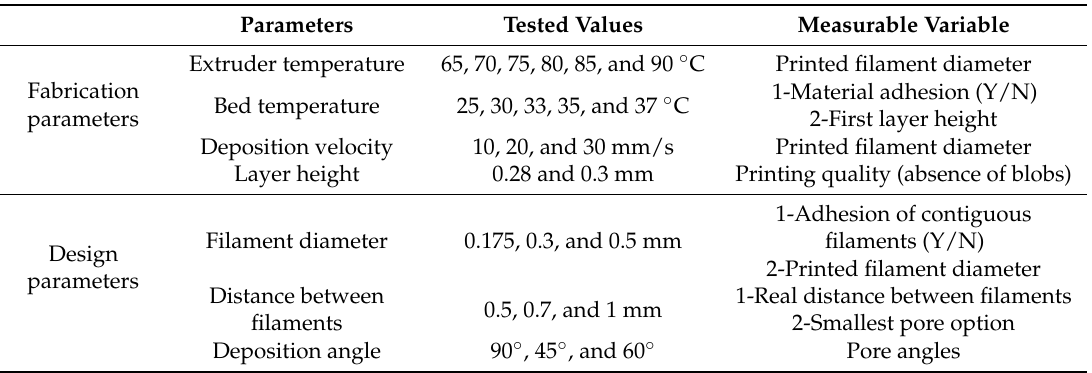
Table 1. Process parameters used for PCL scaffold printing.